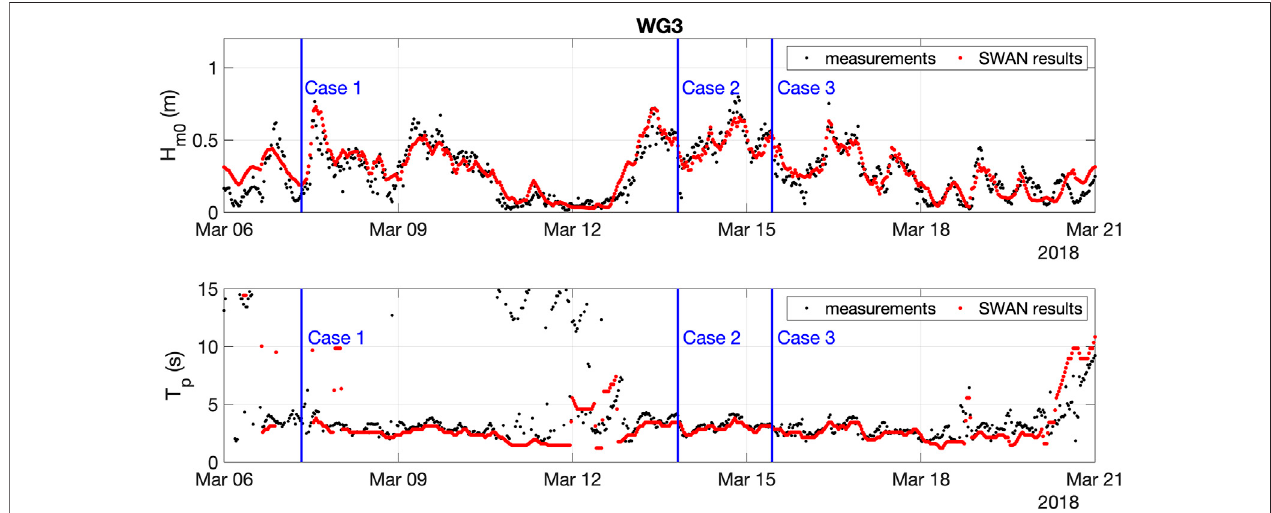
FIGURE 2 | Time series of the measured and modeled (SWAN) H m0 and T p at offshore wave gauge (WG3). Three representative cases are denoted by the blue lines.